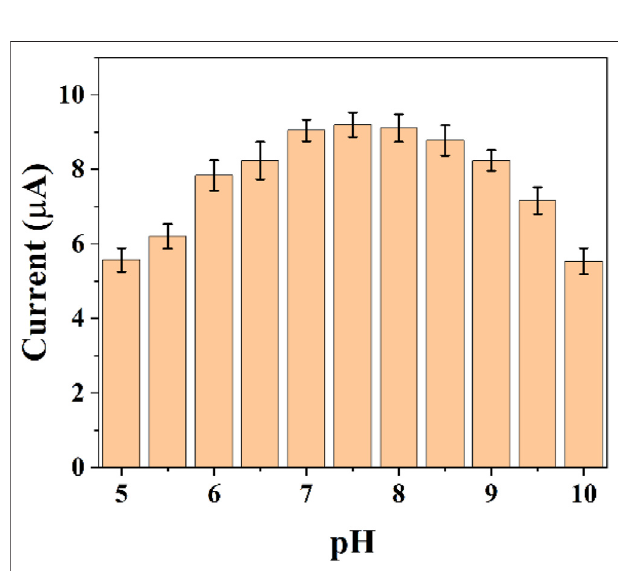
FIGURE3| Reduction peak currentofgraphene- E.coli /GCE atdifferent pH conditions ( n (cid:2)